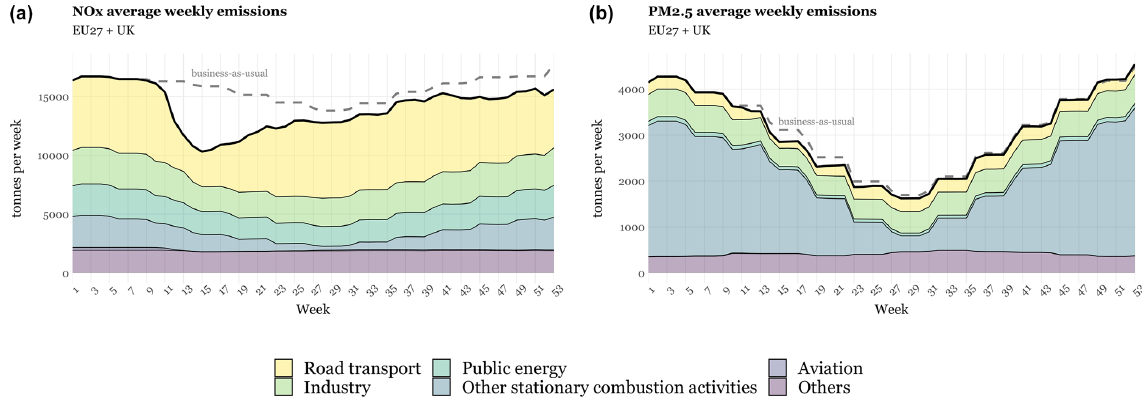
Figure 11. Stacked area charts representing the evolution of the average weekly emissions of NO x (a) and PM 2 . 5 (b) per pollutant sector in EU27 + UK during the COVID-19